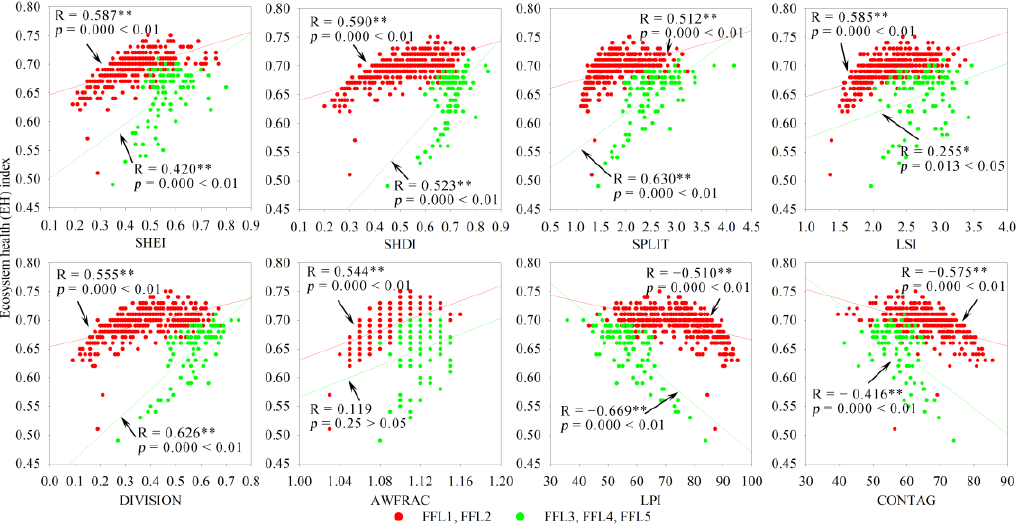
Figure 8. Correlation of landscape composition and configuration with the ecosystem health in forestland + farmland landscape. FFL, forestland + farmland landscape; SHEI, Shannon’s evenness index; SHDI, Shannon’s diversity index; SPLIT, splitting index; LSI, landscape shape index; DIVISION, landscape division index; AWFRAC, area-weighted mean fractal dimension index; LPI, largest patch index; CONTAG, contagion index. * p -values at 5% level; ** p -value at 1% level.